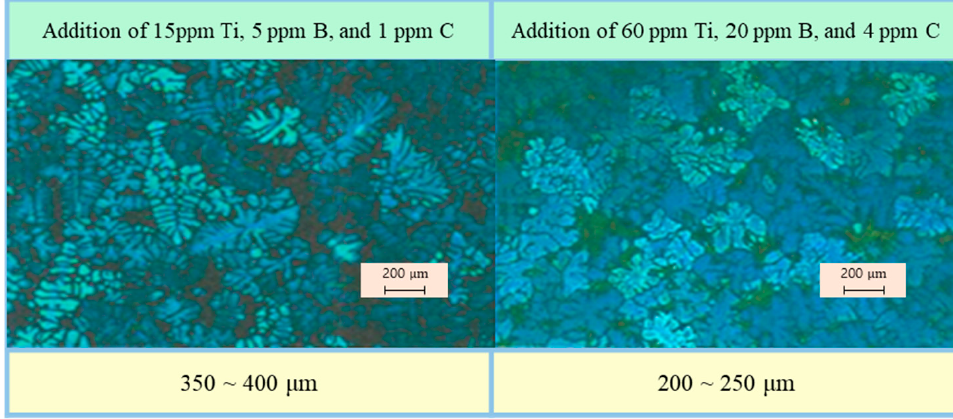
Figure 11. Grain size control for the AC4CH alloy through the chemical addition of Ti, B, and C. 3.3. Refinement of the Secondary Dendrite Arm Spacing (S-DAS) by the Cooling Speed The average S-DAS sizes were measured after fixing the temperature of the molten metal at 730 ◦ C while changing the mold temperature. The results are illustrated in Figure 12. When the mold temperature was adjusted to 400 ◦ C, the average S-DAS was measured as 37.54 µ m. As the mold temperature was further reduced to 370 ◦ C, the average S-DAS also decreased to 16.23 µ m. However, when the mold temperature was further reduced to less than 300 ◦ C, the fluidity of the molten metal decreased, resulting in a filling defect. Therefore, it was confirmed that the optimal mold temperature required to minimize the S-DAS without defect formation was 300 ◦